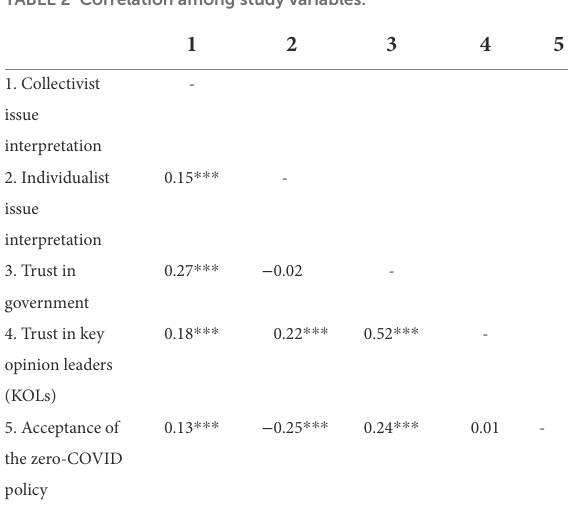
FIGURE 2 Test of the proposed model.